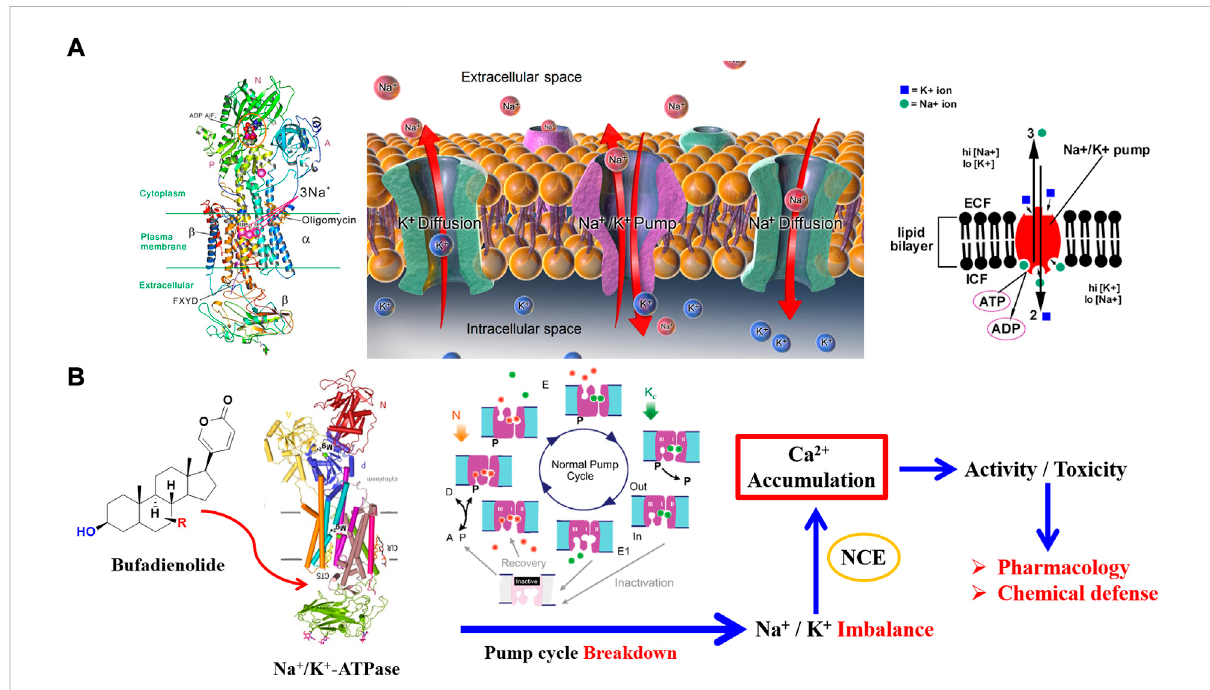
FIGURE 5 Speci fi c inhibition of bufadienolide against Na + /K + ATPase: (A) The crystal structure and function of Na + /K + ATPase; (B) The primary act mechanism of bufadienolide against Na + /K +